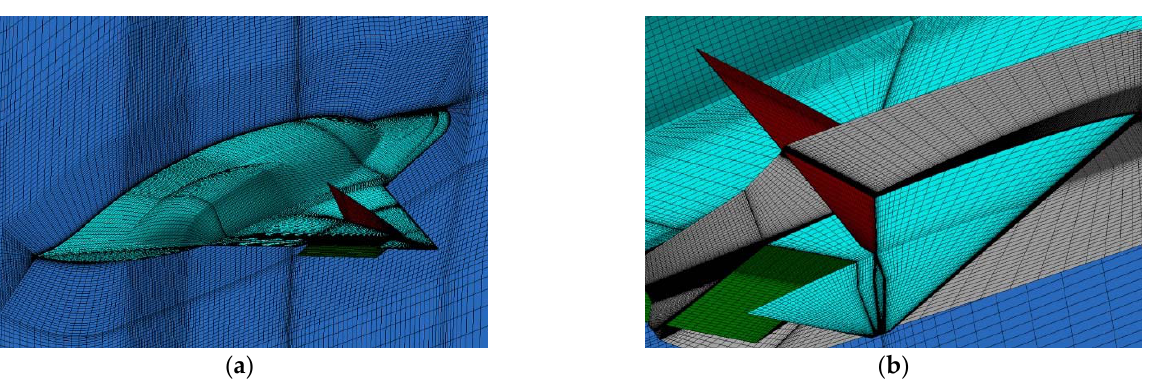
Figure 6. Computation grid for the studied model: ( a ) Surface mesh; ( b ) Mesh around the control surfaces.